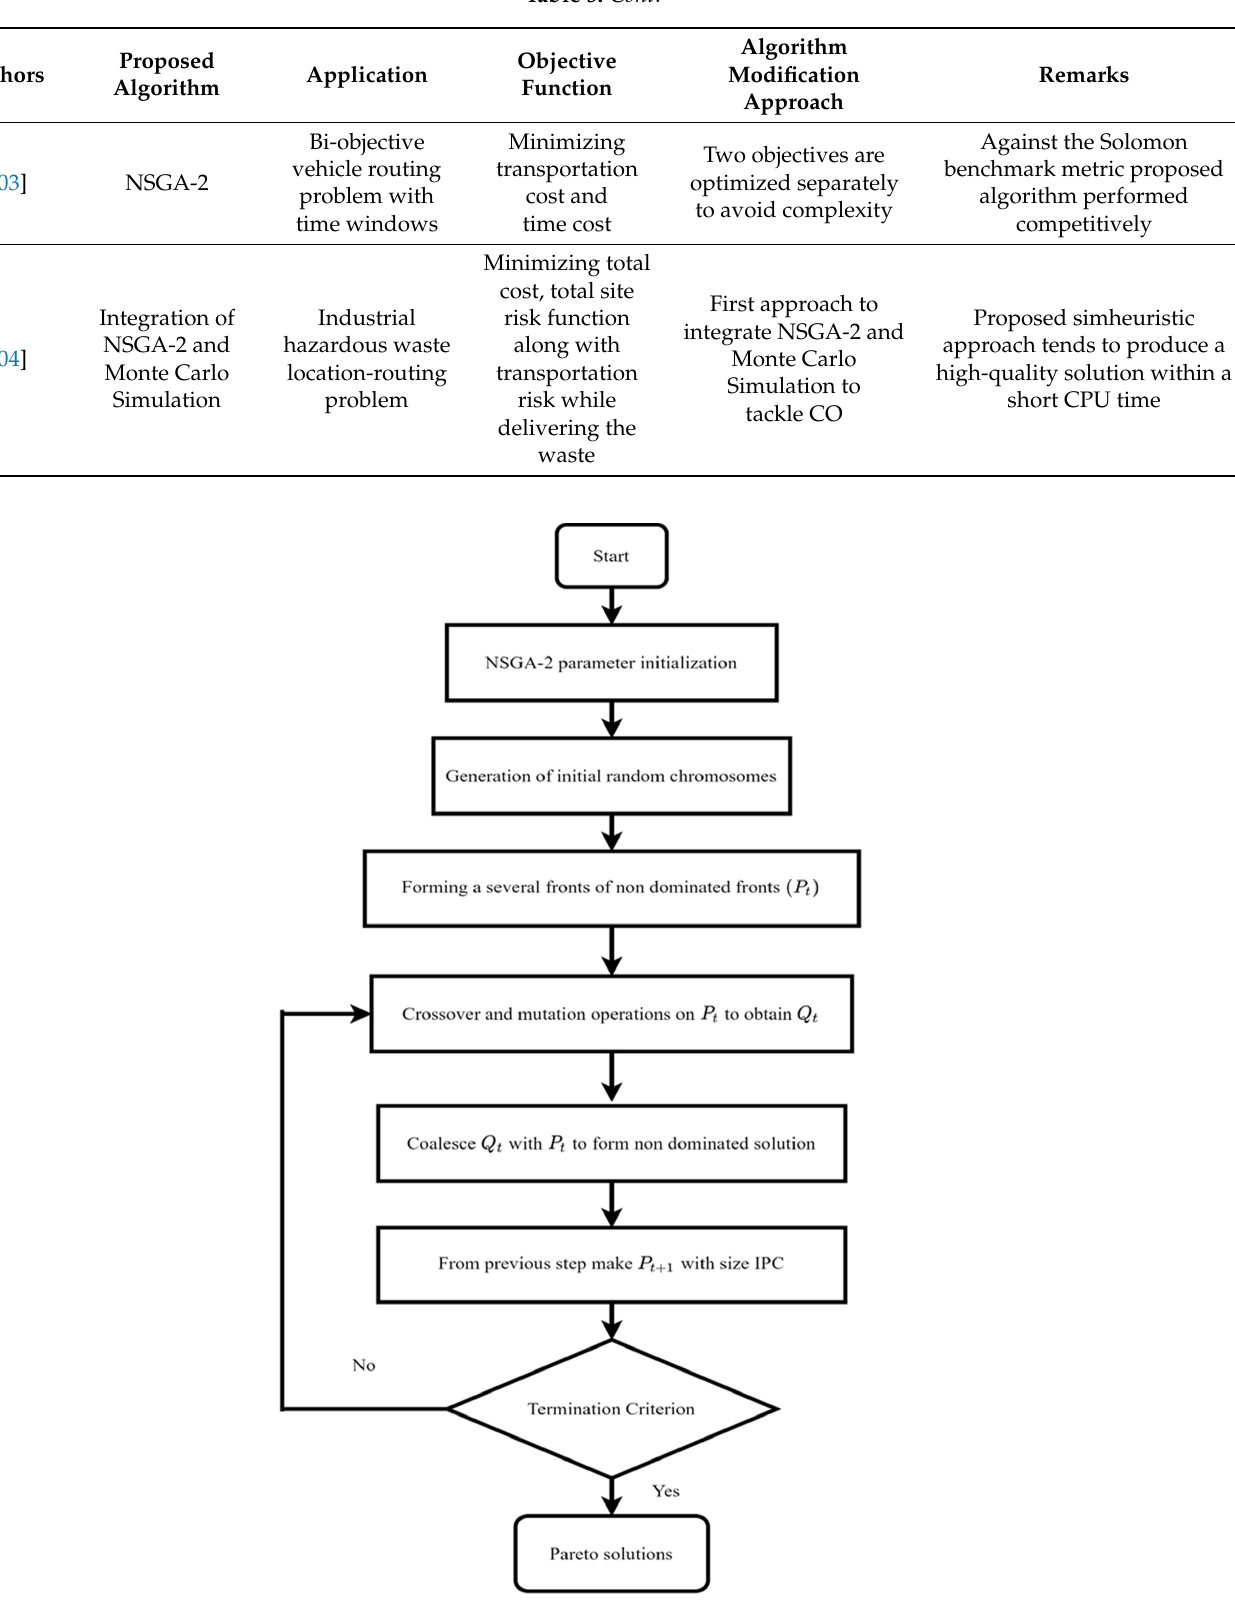
Figure 13. Framework of the NSGA-2 algorithm. Application of NSGA-2 Algorithm in Combinatorial Optimization